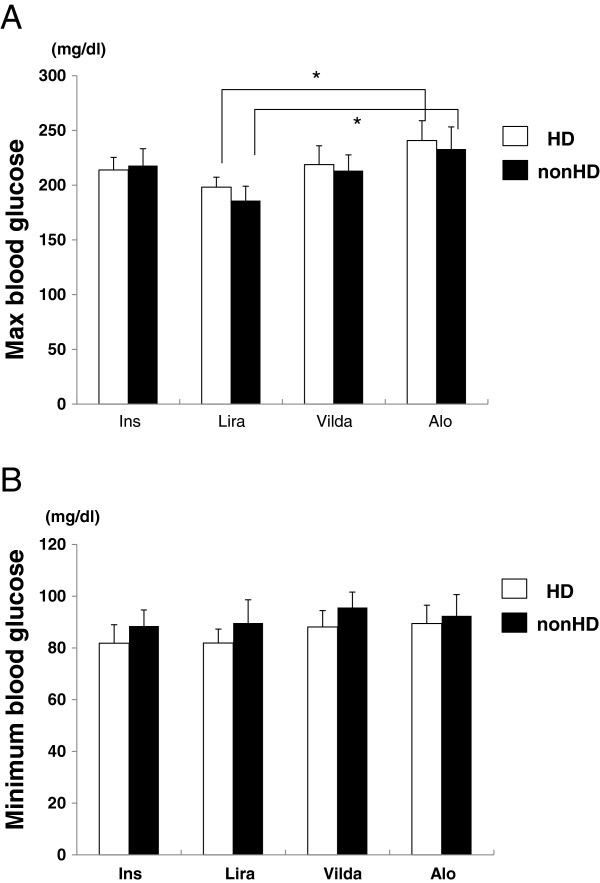
Maximum blood glucose level (A) and minimum blood glucose level (B). Data are presented as mean ± SEM, *p < 0.05, n = 10, Ins; insulin, Lira; once-daily injection of 0.3 mg liraglutide, Vilda; once-daily oral administration of 50 mg vildagliptin, Alo; once-daily oral administration of 6.25 mg alogliptin.